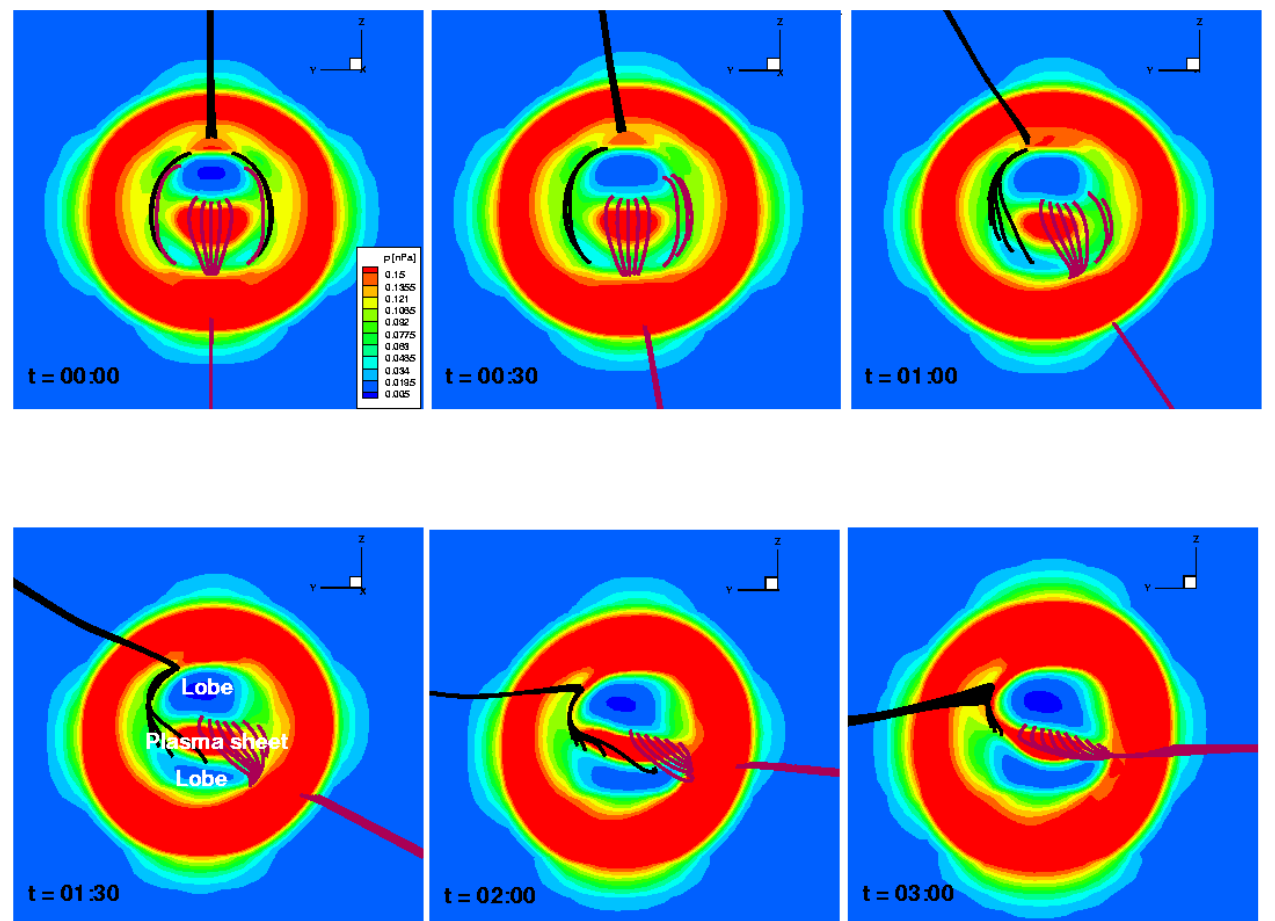
Fig. 12. Cross sectional panel in the Y-Z plane of the plasma pressure at x = − 10 R E . The newly opened field lines are also shown. Black line indicates those that connect to the Southern Hemisphere and red to the Northern